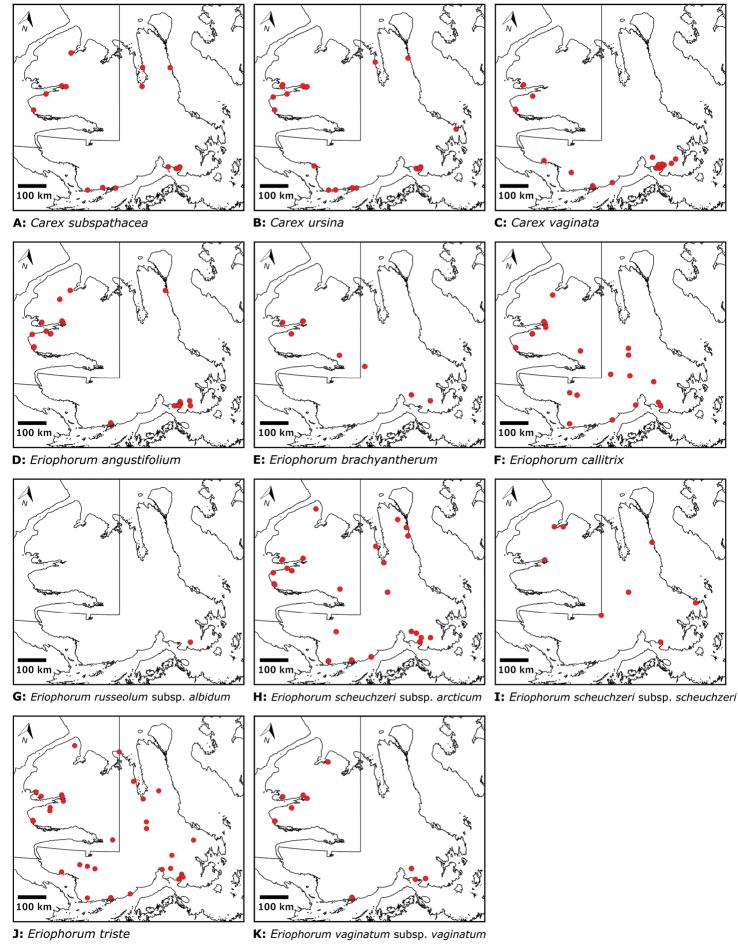
Species distribution maps. Cyperaceae: ACarex
subspathaceaBCarex
ursinaCCarex
vaginataDEriophorum
angustifoliumEEriophorum
brachyantherumFEriophorum
callitrixGEriophorum
russeolum
subsp.
albidumHEriophorum
scheuchzeri
subsp.
arcticumIEriophorum
scheuchzeri
subsp.
scheuchzeriJEriophorum
tristeKEriophorum
vaginatum
subsp.
vaginatum.